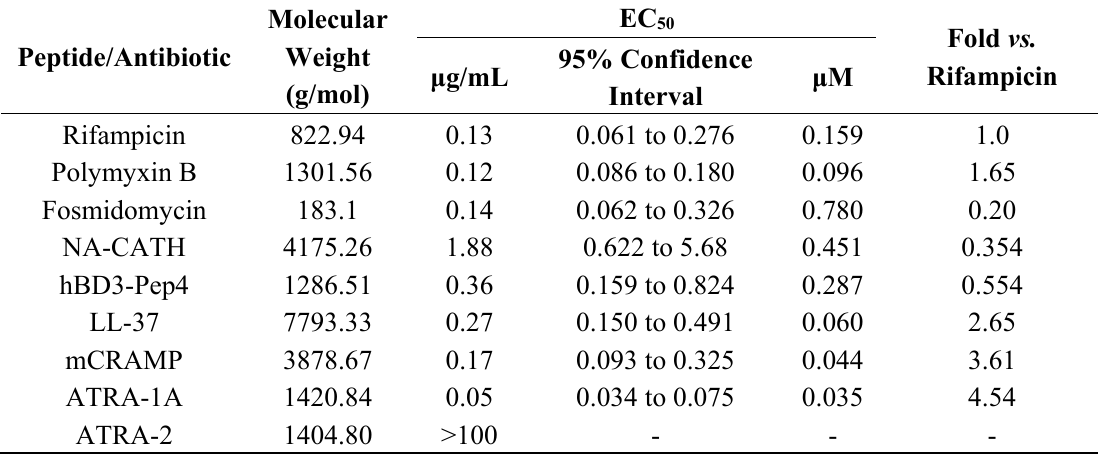
Table 2. EC 50 of peptides and antibiotics against M. smegmatis